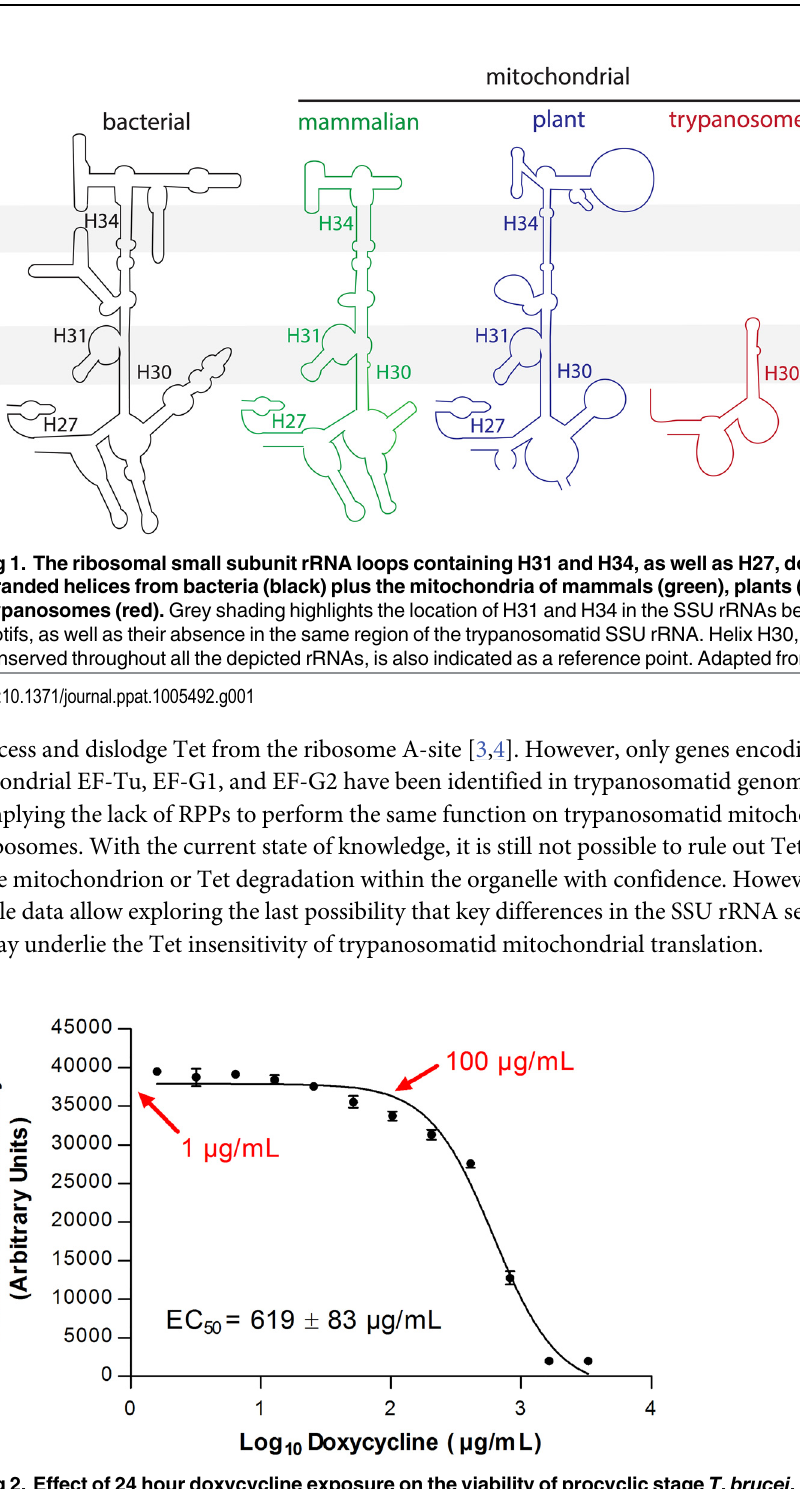
Fig 2. Effect of 24 hour doxycycline exposure on the viability of procyclic stage T . brucei . Data points represent the mean cell viability ± standard error of the mean (SEM) ( n = 4), as measured by the Alamar Blue fluorescent dye assay. X -axis, μ g/ml doxycycline (log scale); y -axis Alamar Blue fluorescence intensity in arbitrary units; doxycycline EC 50 value calculated from curve given on lower left. Red arrows indicate points corresponding to 1 and 100 μ g/ml concentrations on the x -axis. The assay was performed as previously described